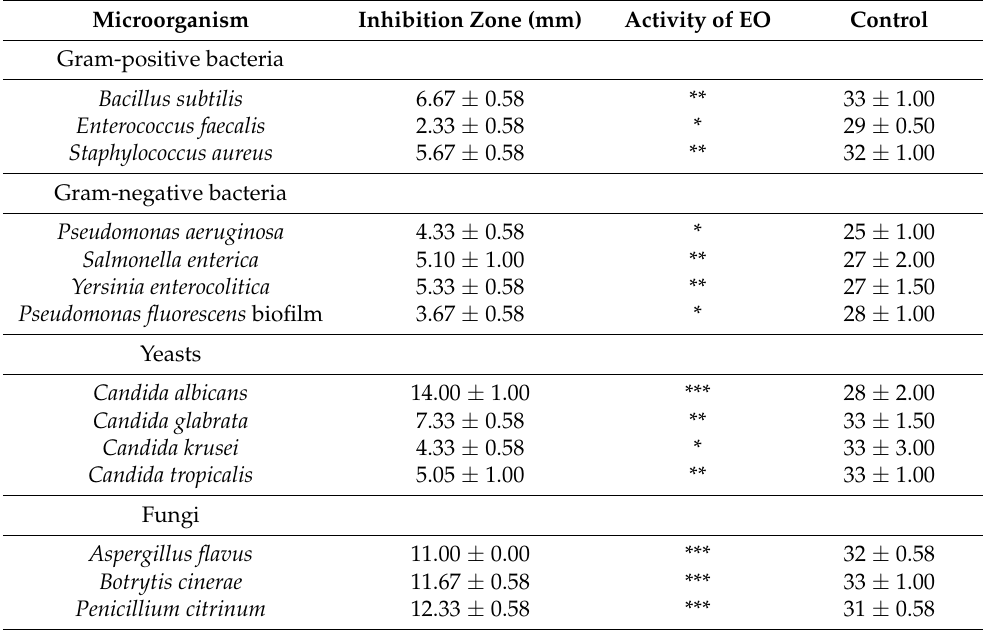
Table 3. Antimicrobial activity of Eucalyptus globulus Essential